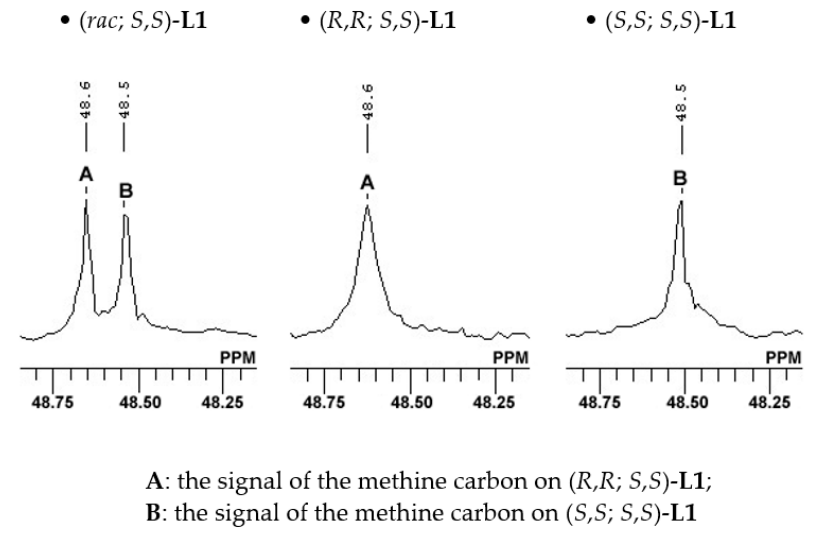
Figure 4. 13 C NMR spectrum of the methine carbon adjacent to isobutyl substituent.